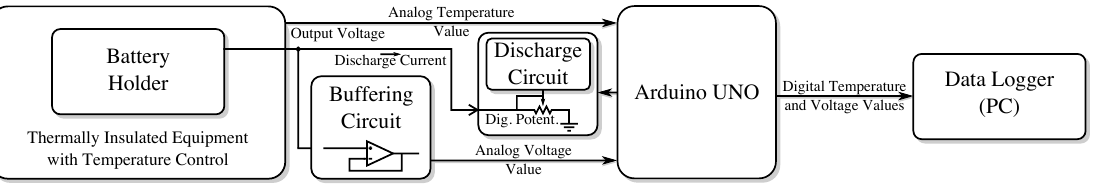
Figure 5. Connectivity scheme of the test-bed system.